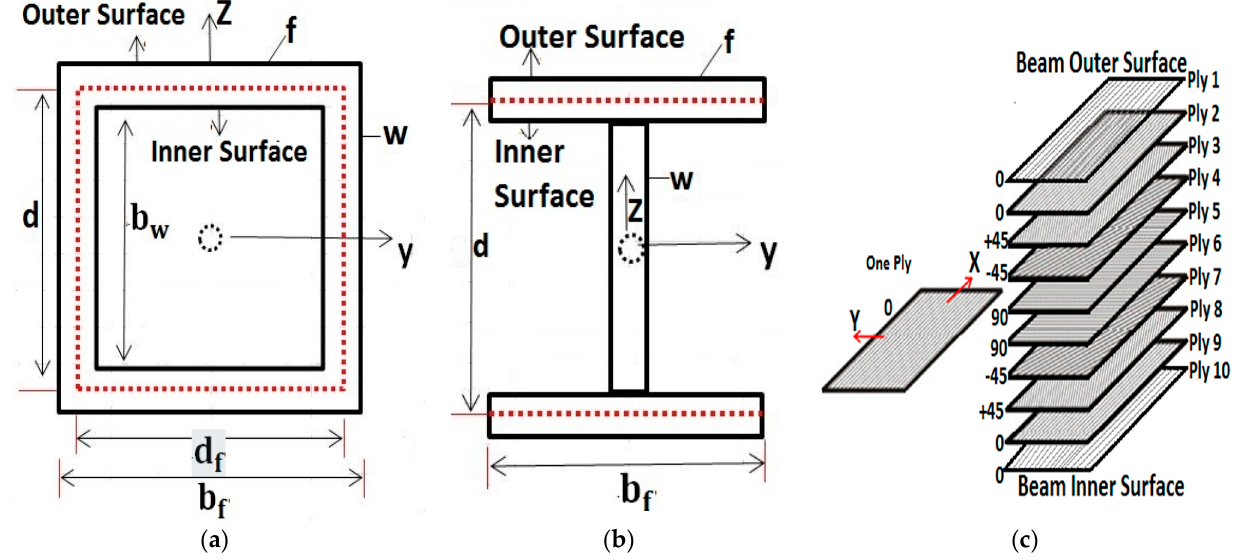
Figure 3. Beam sections: ( a ) square beam, ( b ) I-beam, and ( c ) laminate schematic of the plies for L8 = [ 0 2 / ± 45/90 ] . s